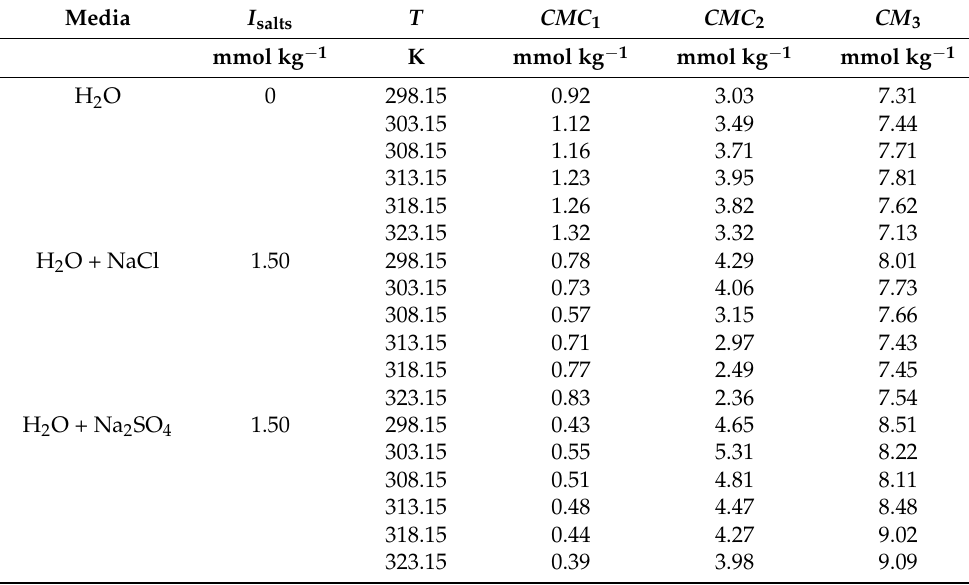
Table 3. The CMC values of the CPC + 0.1% ( w / v ) PVP mixture in H 2 O, H 2 O + NaCl, and H 2 O + Na 2 SO 4 media at different